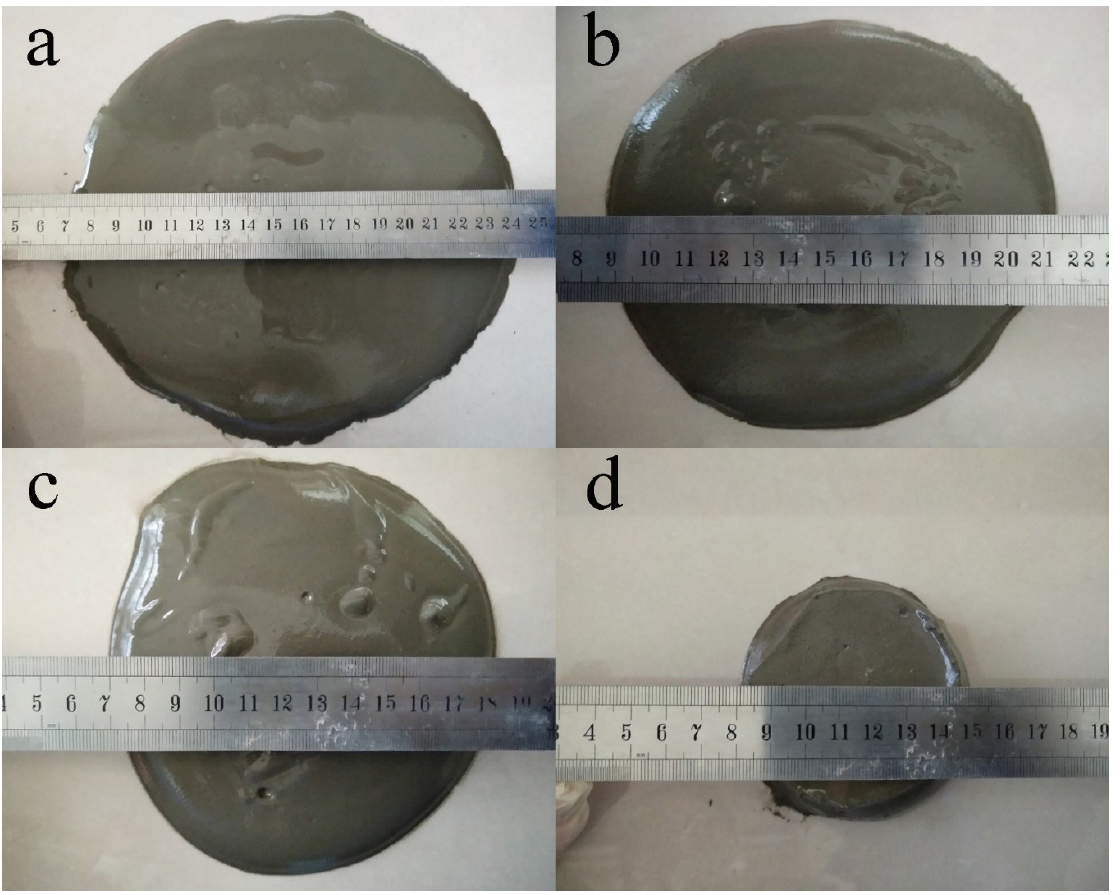
Figure 2. The flowability of cement paste with various replacement level of metakaolin: ( a ) 0; ( b ) 5%; ( c ) 10%; ( d ) 20%.